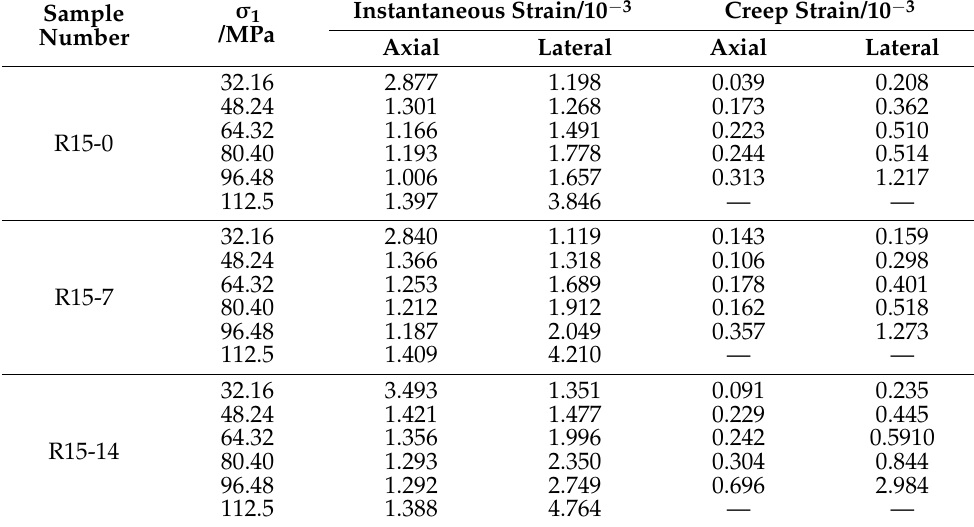
Table 2. Creep strain for an initial confining pressure of 15